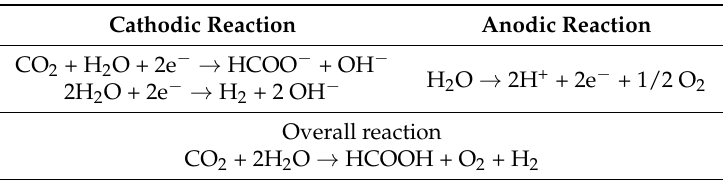
Table 1. Main and side